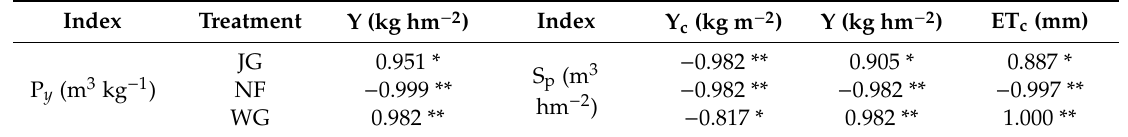
Table 3. Correlations between indexes affecting water saving potential.